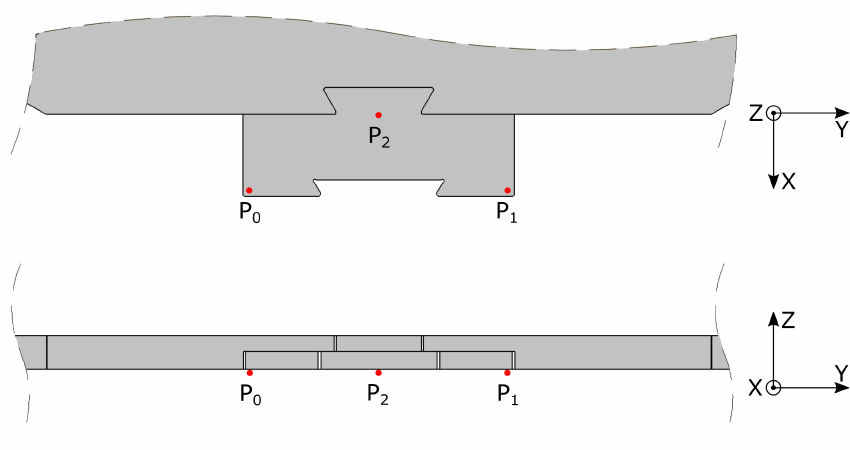
Figure 6. Position of points and coordinate system alignment depicted on a section cut of the